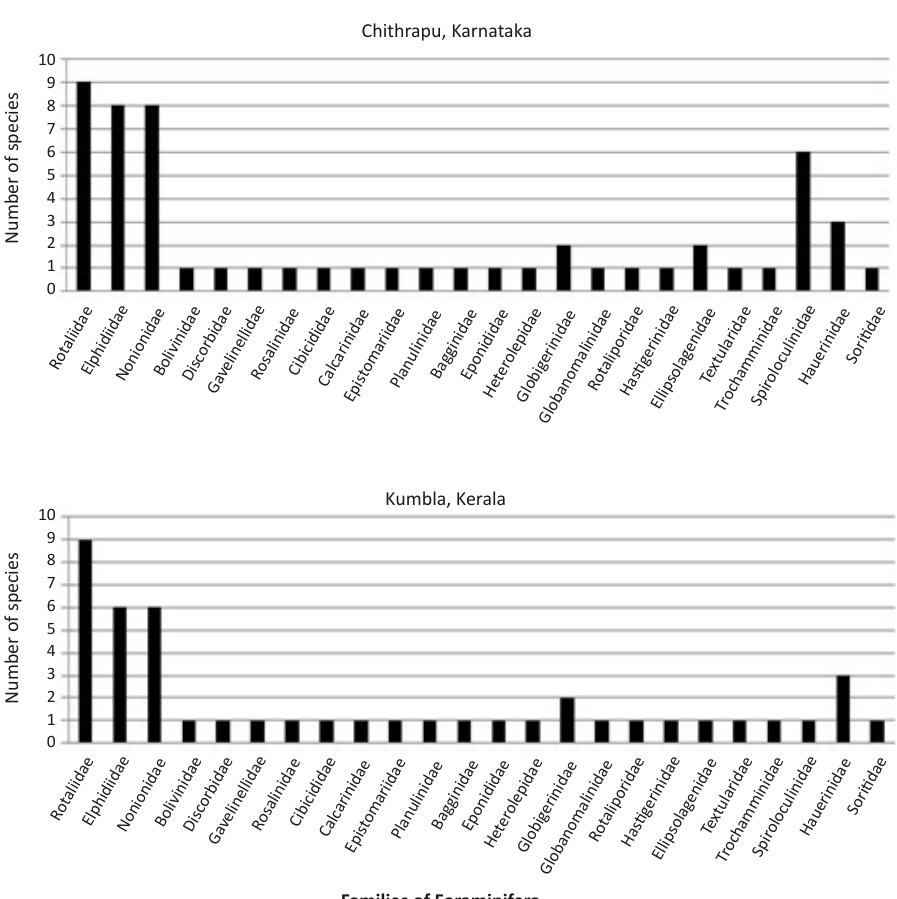
Families of Foraminifera Figure 1. Graph showing the distribution of families of Foraminifera in sediment cores